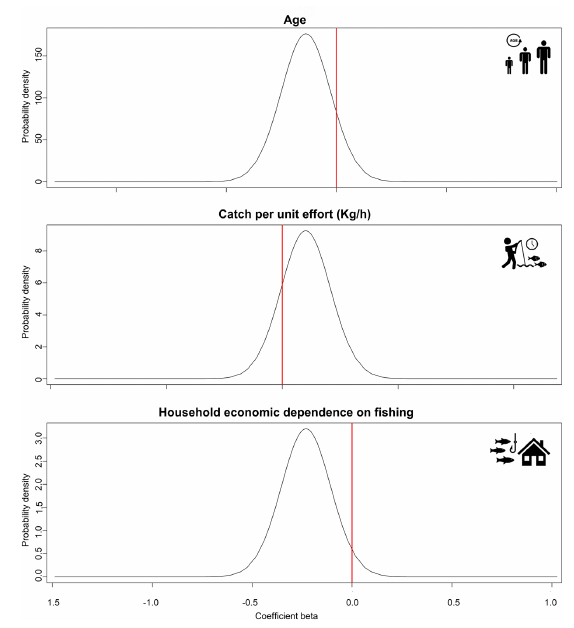
Fig. 5 . Posterior marginal distributions of the relevant variables of the final Bayesian model: fisher’s age (top), their individual average capture per unit effort (middle), and the household economic dependence on fishing